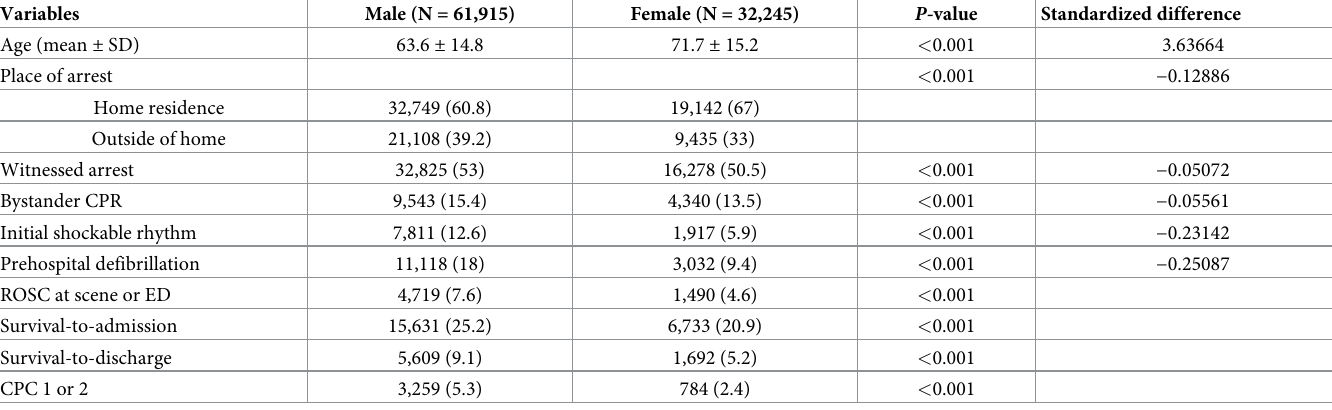
Table 1. Characteristics of patients with out-of-hospital arrest by sex (total number = 94,160). Variables